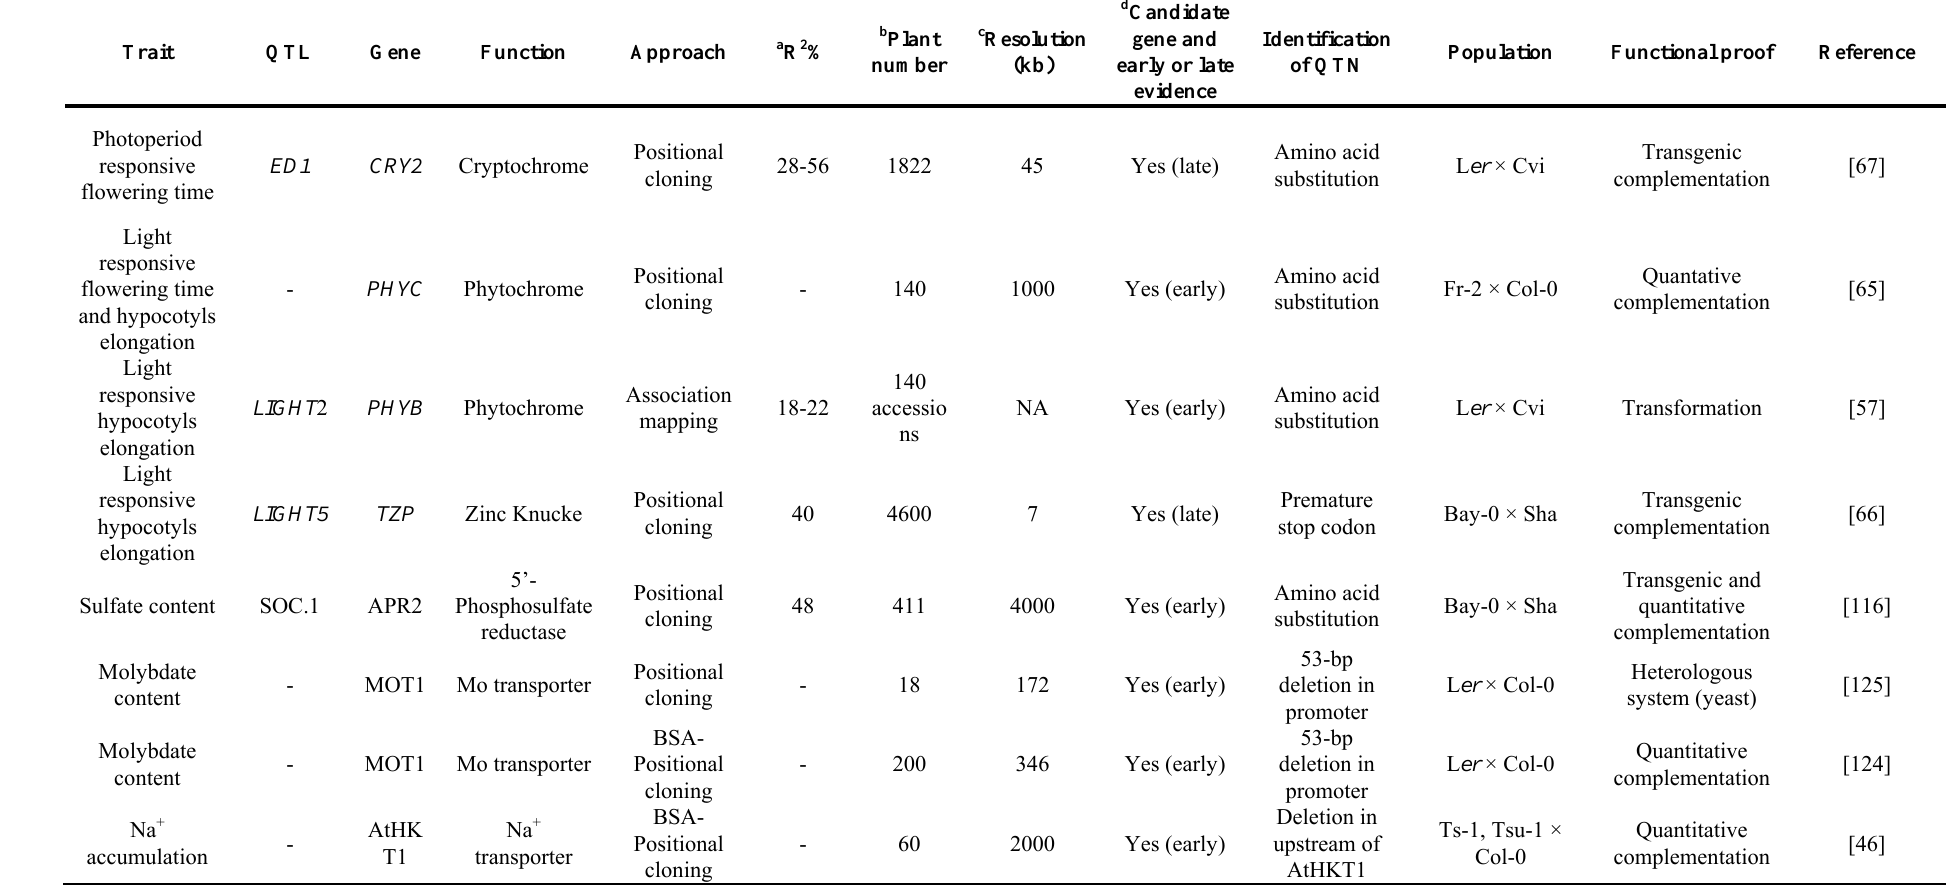
Table 2. Summary of the characteristics of the QTLs cloned, for abiotic environment-responsive traits in Arabidopsis